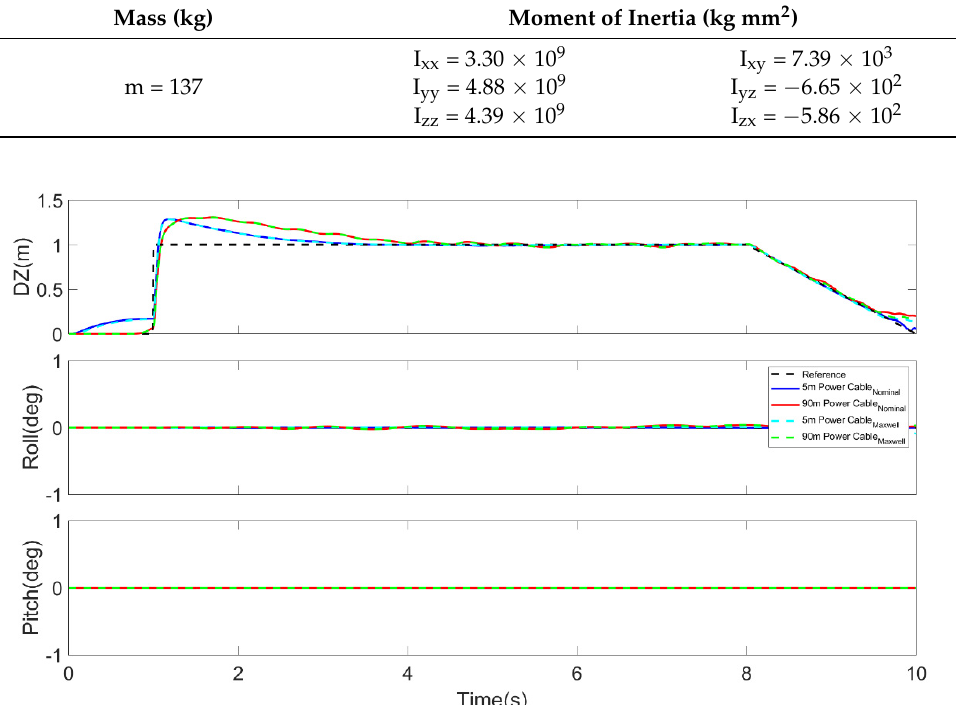
Figure 14. Altitude, roll and pitch attitude of the tethered multicopter during altitude control simu- lation for various torsional stiffnesses and altitude